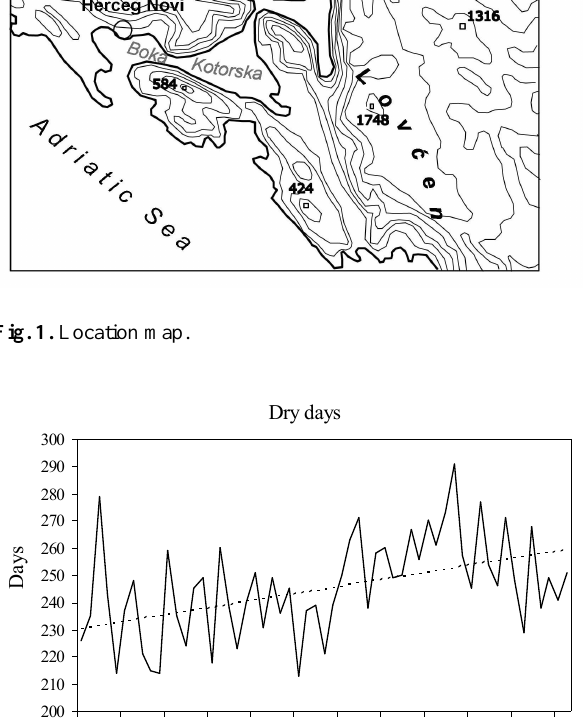
Fig. 2 . Number of dry days for the Crkvice station for the period 1951-2007. Dashed line indicates Sen’s estimator Fig. 2. Number of dry days for the Crkvice station for the period of the slope. 1951–2007. Dashed line indicates Sen’s estimator of the slope.